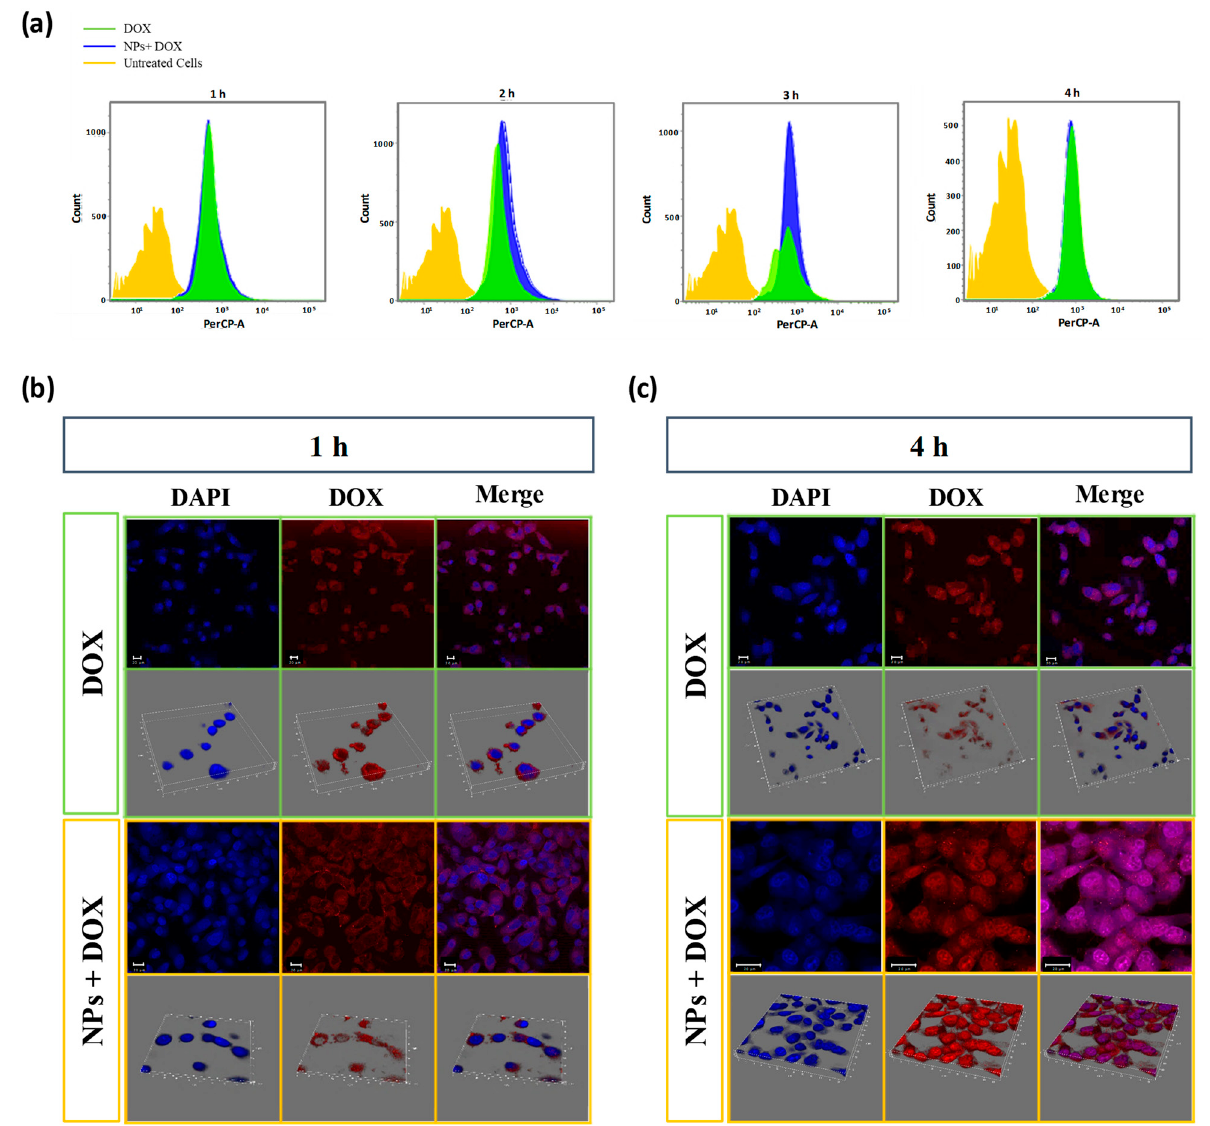
Figure 5. ( a ) Flow cytometry analysis of cellular uptake of α 1 -acid glycoprotein-conjugated hyaluronic acid nanoparticles (AGP-HA NPs) + DOX and free DOX in MDA-MB-231 cells incubated for 1, 2, 3, and 4h. ( b , c ) CLSM images of α 1 -acid glycoprotein-conjugated hyaluronic acid nanoparticles (AGP-HA NPs) + DOX and free DOX in MDA-MB-231 cells incubated for 1 h ( b ) and 4h ( c ). Nuclei were stained in blue with DAPI dyes, and DOX fluorescence in cells is red.